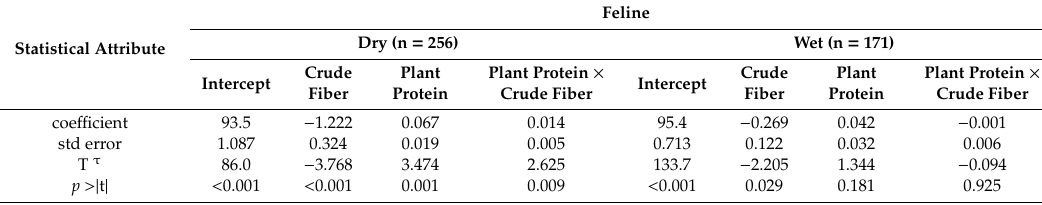
Table 5. The effect of percent of total protein as plant protein and fiber (percent of dry matter) on protein digestibility in the cat.